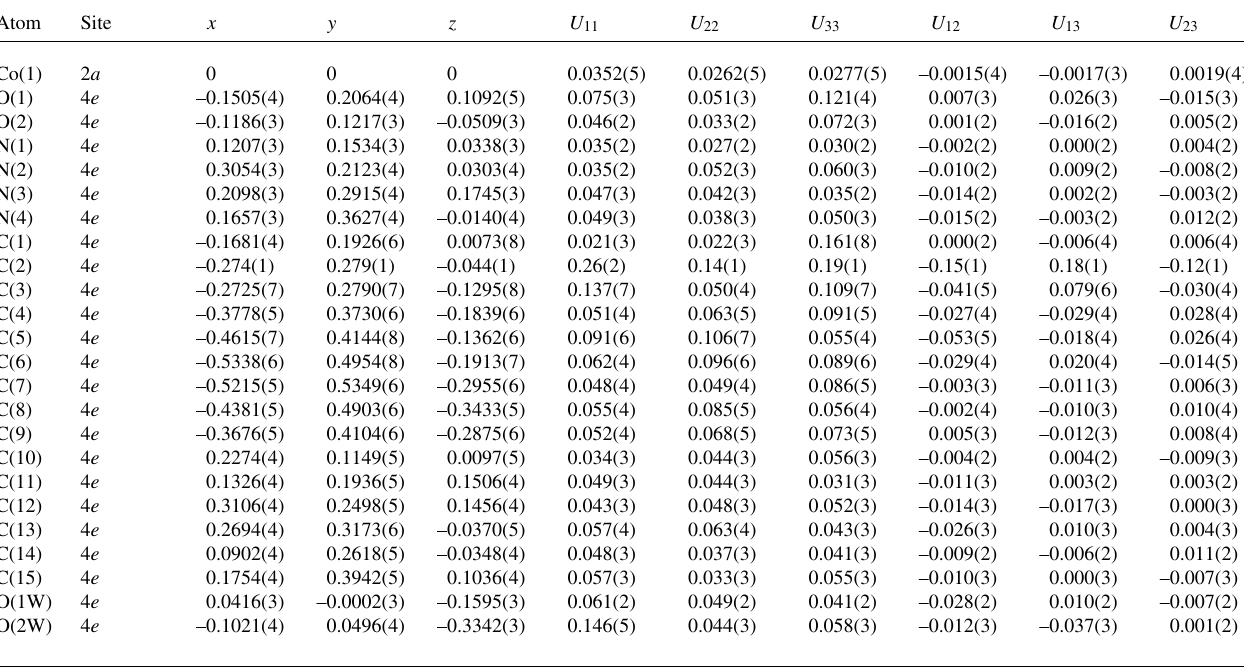
Table 3. Atomic coordinates and displacement parameters (in Å 2 )